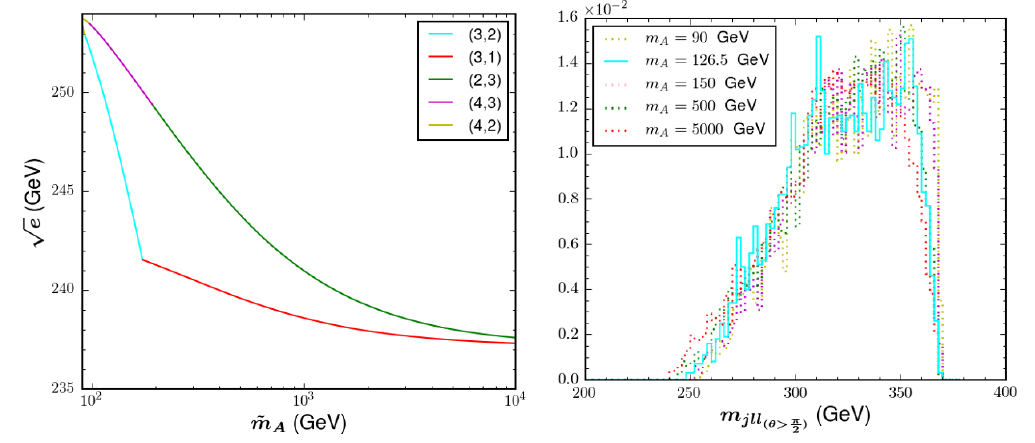
Figure 20 . The same as (cid:12)gure 19, but for the kinematic endpoint p e and the corresponding m jll ( (cid:18)> (cid:25) 2 )